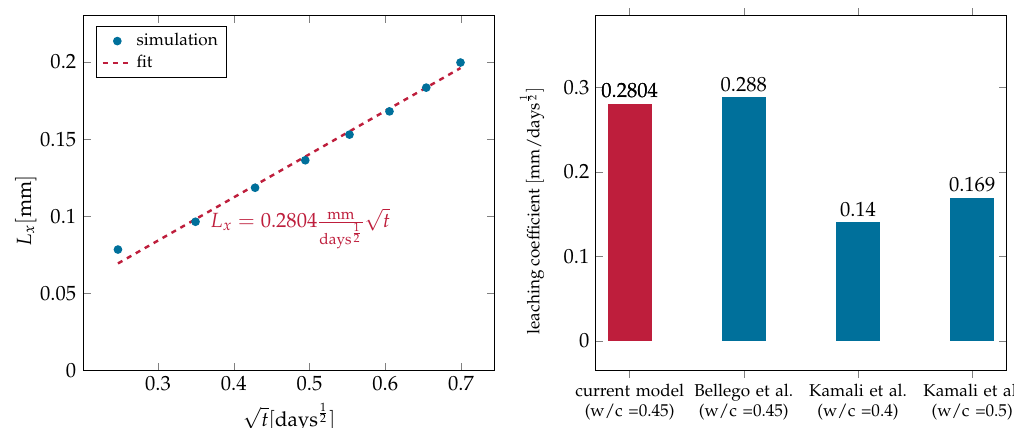
Figure 12. Position of the the average dissolution front together with a fit to obtain the resulting leaching kinetics parameter ( left ) and the comparison to the kinetic parameters from the literature ( right